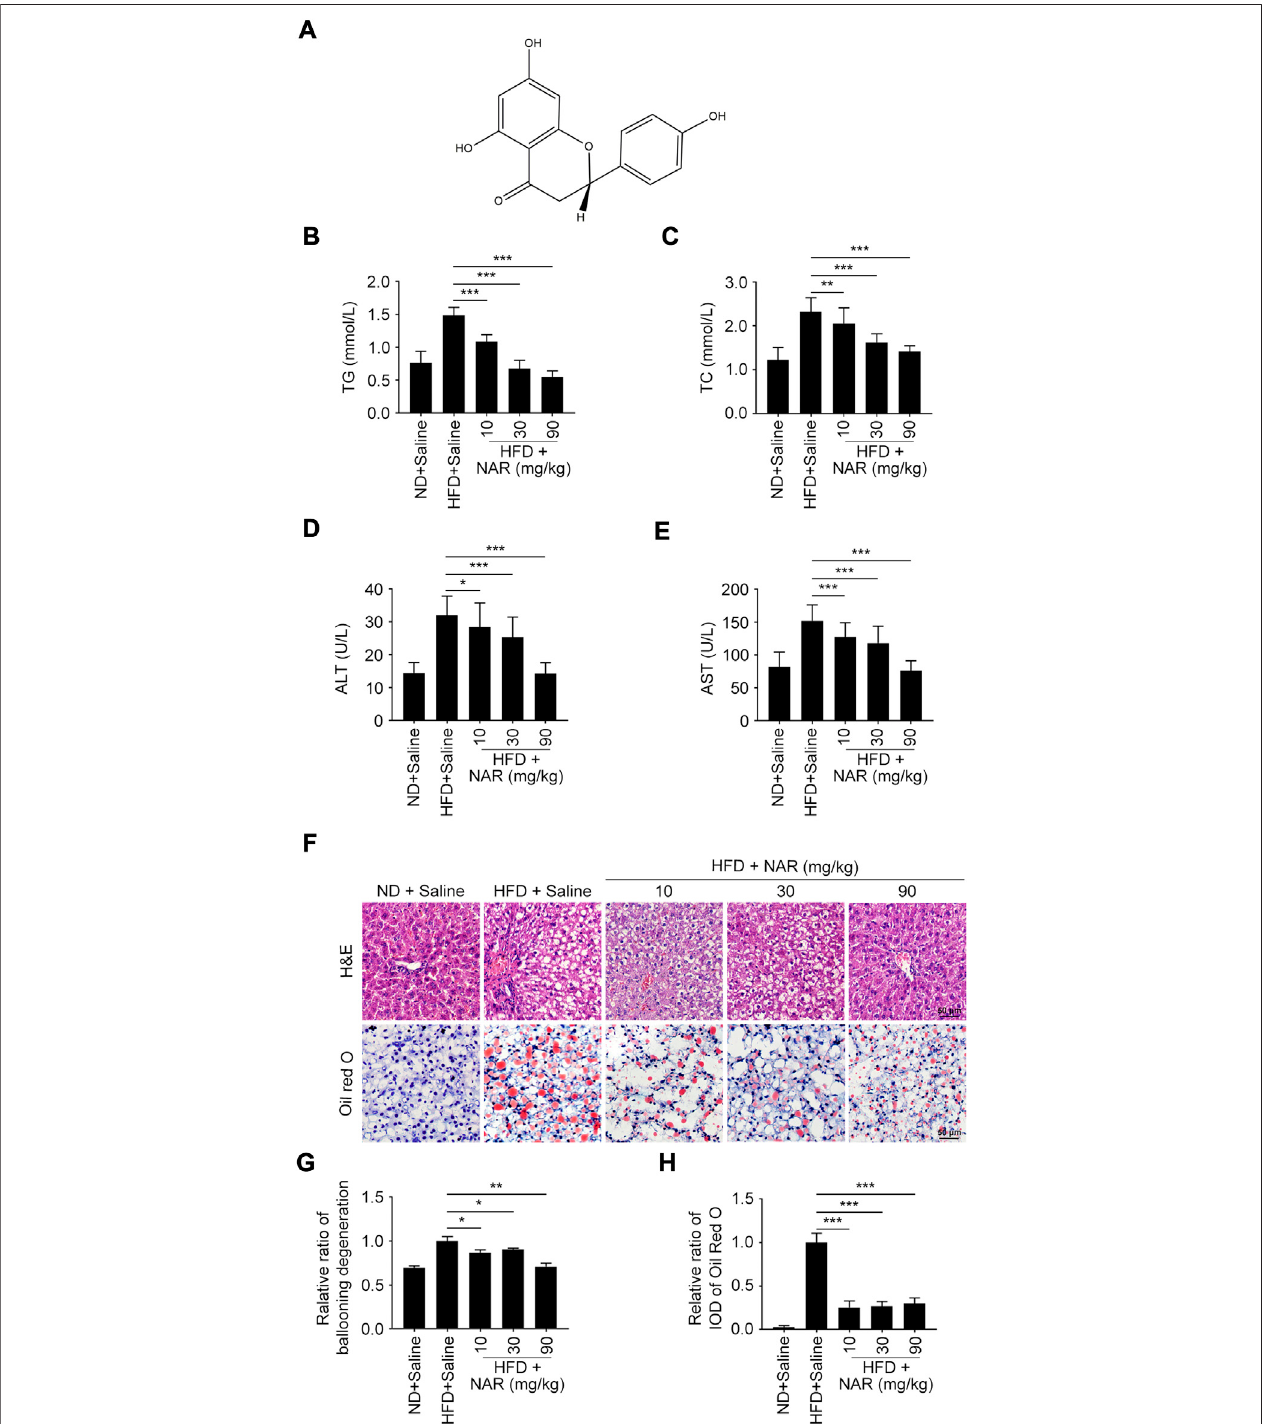
FIGURE 1 | NAR attenuates HFD-induced NAFLD in rats. Male Sprague-Dawley rats aged 8 weeks were fed with an HFD or ND for 12 weeks. Then they were orallyadministered withNARat 10,30, or90 mg/kgfor2 weeks n (cid:1) 5rats per group. (A) Chemical structure ofNAR. (B – E) Serum level ofTG,TC, ALT,and AST. (F – H) Representative H&E and oil red O staining ofhepatic sections (the objective ampli fi cation 10 × ). Bars represent50 μ M. All values were expressed as the mean ± SD from three ormore independent experiments. *** p < 0.001;** p < 0.01; * p < 0.05vs. HFD group.Abbreviation: NAR,naringenin;NAFLD,nonalcoholicfatty liver disease; ND, normal diet; HFD, high-fat diet; TG, triglyceride; TC, total cholesterol; ALT, alanine aminotransferase; AST, aspartate aminotransferase; IOD, integrated optical density; H&E, hematoxylin and eosin.